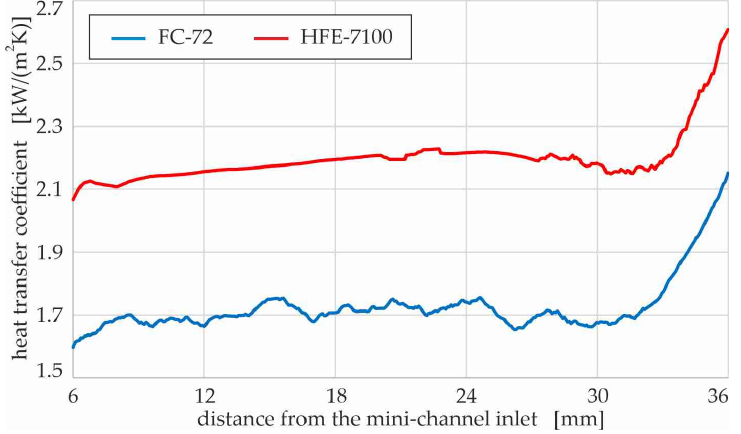
Figure 11. The heat transfer coefficient versus the distance from the mini-channel inlet, assuming two working fluids: FC-72 and HFE-7100 in numerical simulations due to Simcenter STAR-CCM+ software.